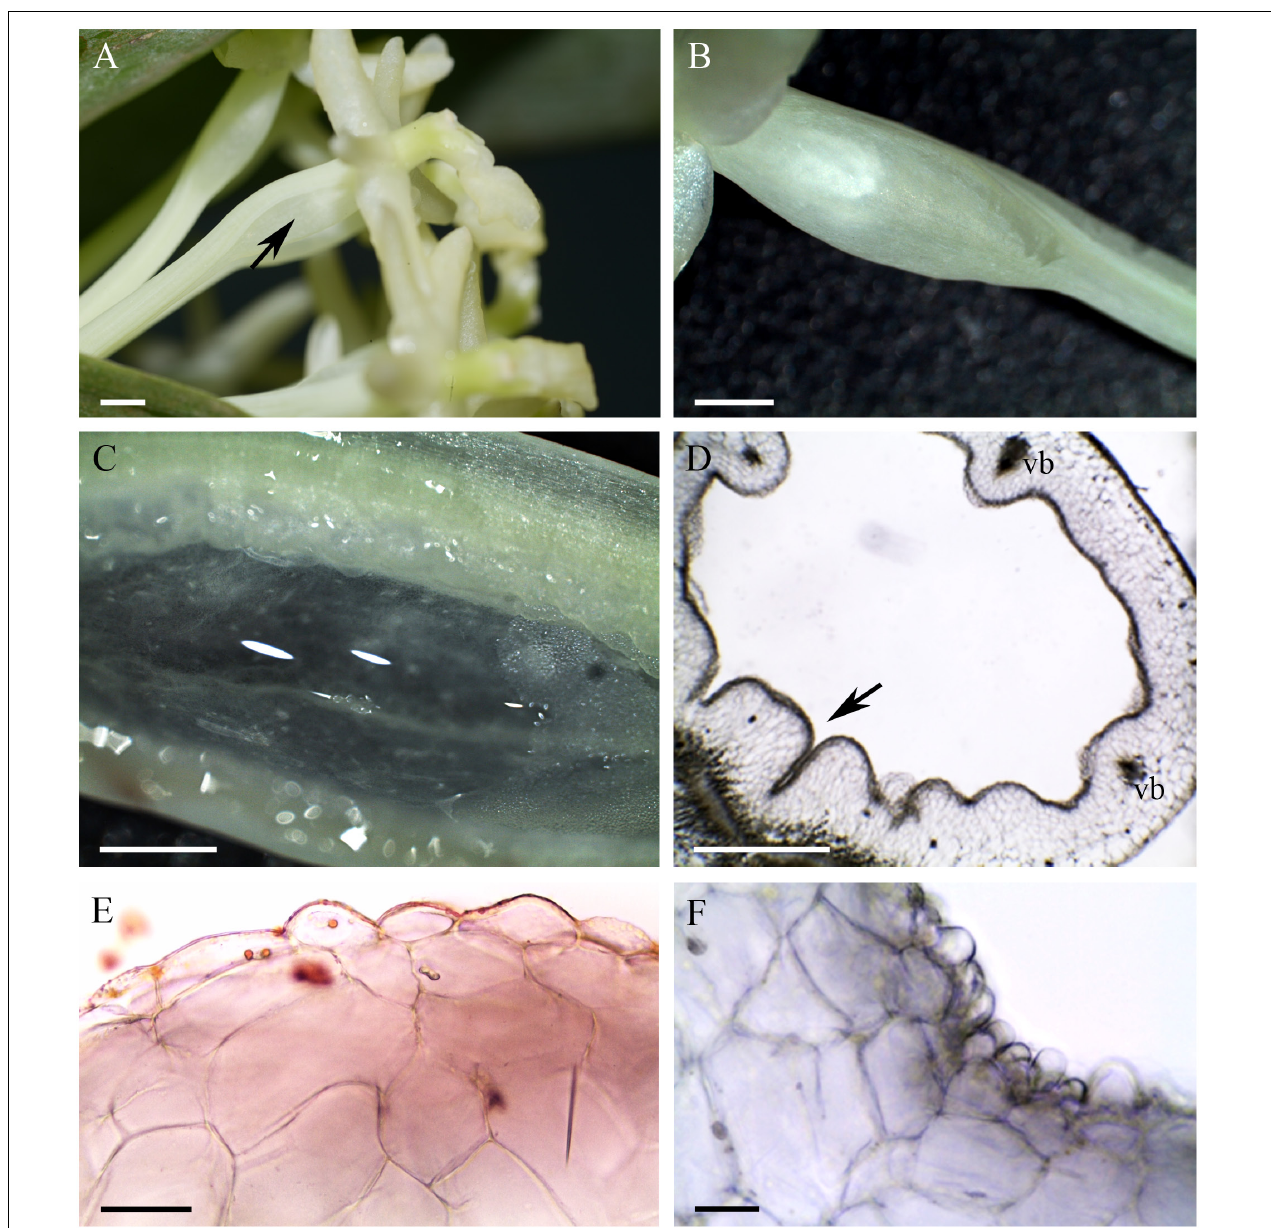
FIGURE 5 | Epidendrum vesicatum . (A) Habit of the flower, cuniculus marked by arrow. (B) Lateral view of cuniculus. (C) Longitudinal section of cuniculus containing copious nectar. (D) Transverse section of cuniculus stained with IKI showing secretory tissue (arrow) adjacent to the transmitting tract. (E) Transverse section of secretory tissue stained with Sudan III. Note the thin cuticle present on secretory cells. (F) Detail of transverse section stained with IKI; note papillose epidermal cells and the absence of starch grains. Scale bars: A,B = 2mm, C,D = 1 mm; E,F = 20 µ m.